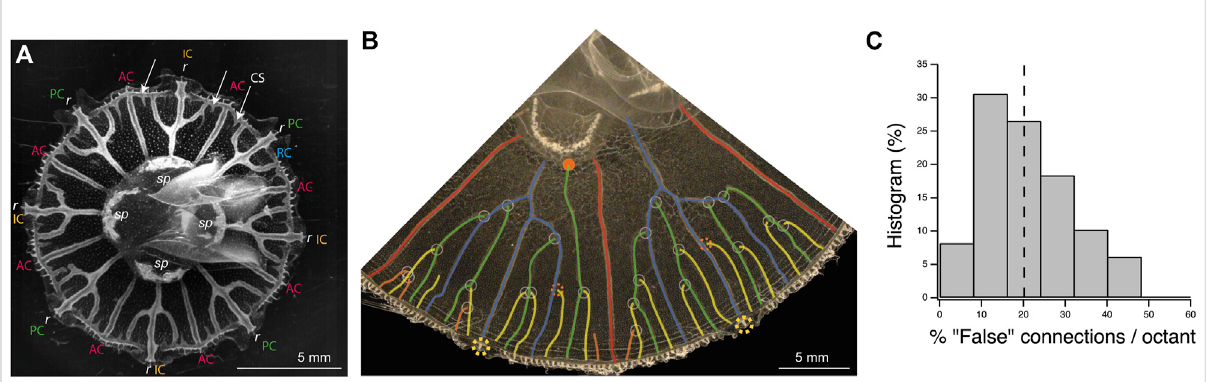
FIGURE 1 Structure and morphogenesisof thecanalnetwork ofthegastrovascular systemofthejelly fi sh Aurelia . (A) Picture ofajuvenilejelly fi shshowing the structure of the gastrovascular system. There are typically four stomach pouches ( sp ), eight sensory organs, or rhopalium ( r ). At the periphery of the jelly fi sh there is a ring canal (RC in blue). Connecting this ring canal, from the sides of the stomach pouches, there are typically eight straight adradial canals (AC in red). Between these adradial canals, other canals connect either the stomach pouch, the perradial canal (PC in green), or the junction between two stomach pouches, the interradial canal (IC in orange), to the rhopalia. New canal sprouts (CS) sprout from the ring canal (arrows). (B) Picture of two octants of a later developmental stage (original in Supplementary Figure S2). The sprouting canals have reconnected to older ones, forming branched perradial and interradial canal systems (rhopalia, yellow dashed circles; adradial canals, and red; original trifurcate canals, blue). The sprouting canals have the tendency to reconnect to the youngest side canal (white circles), leading in theory to a speci fi c fractal tree shape. The four (green) canals sprouting in the two intervals between the fork and the two intervals near the side straight canals (red) would connect to side branches of the original (blue) fork. The next eight canals (yellow) would connect to the previous one (green). Also, the next generation (orange) would connect to the previous one (yellow). Some connections do not follow this pattern and either reconnect to older ones (dashed red circles) or even directly to the stomach pouch (red disk). Some irregular growth is also visible on the left (perradial canals), leading to mixingofgenerations,assomefourth(orange)canalshavealreadyappeared,andevenconnected,while somethirdorder(yellow)generationshave not appeared yet or reconnected. (C) Histogram of the percentage of “ false ” connections (i.e., canal connections not made to the closest younger canal)inmidsizejelly fi shasinB,peroctant(sevenjelly fi shwitheightoctantsandonewithnineoctants n =65octants).Thereare,forinstance,10%of octants present between 32% and 40% of false connections. The median value (dashed line) is 20%.